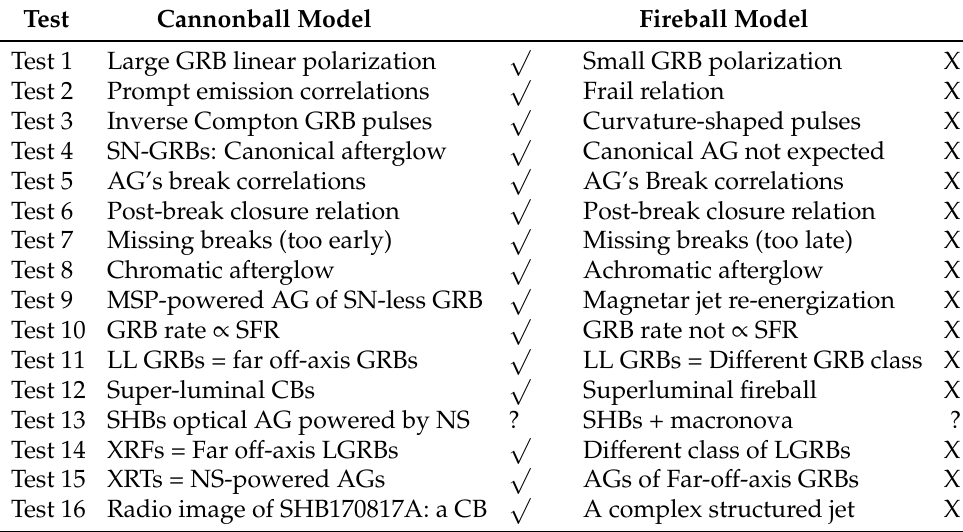
Table 3. Critical Tests of The Cannonball and Fireball models of GRBs and